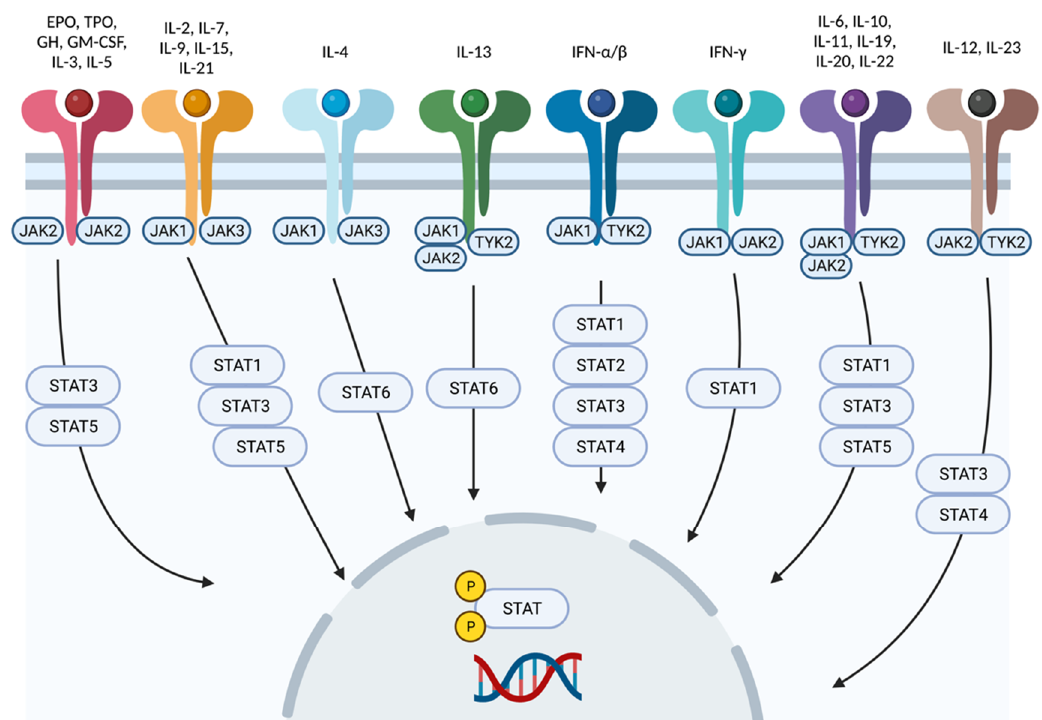
Figure 2. Cytokine signaling mediated by Jak-STAT. Each cytokine interacts with a particular combi- nation of Jak-STAT molecules. Created with BioRender.com (accessed on 14 January 2023). Abbrevia- tions: Jak, Janus kinase; STAT, signal transducer and activator of transcription; Tyk2, tyrosine kinase 2; IFN, interferon; IL, interleukin; EPO, erythropoietin; GH, growth hormone; TPO, thrombopoietin; GM-CSF, granulocyte macrophage colony-stimulating factor.